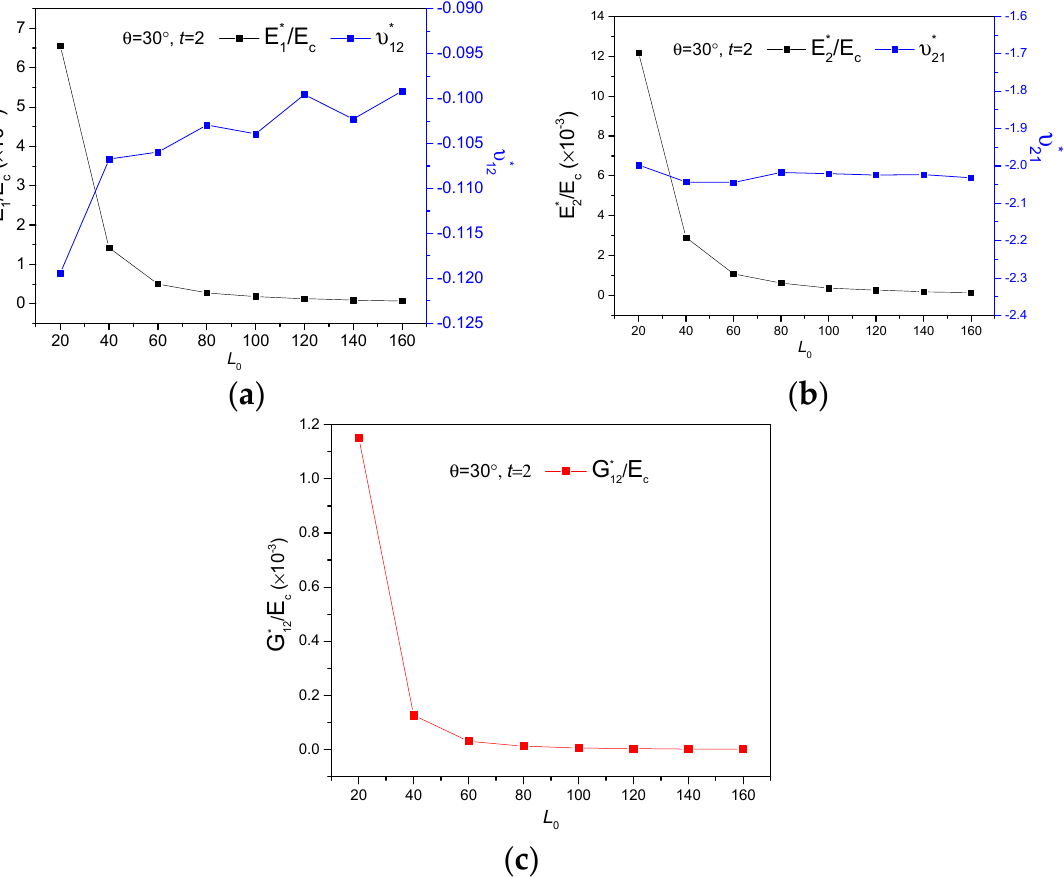
Figure 4. The variations of e ff ective mechanical properties verse length L 0 : ( a ) E ∗ and ν ∗ , ( c ) G ∗ / E c 21 12